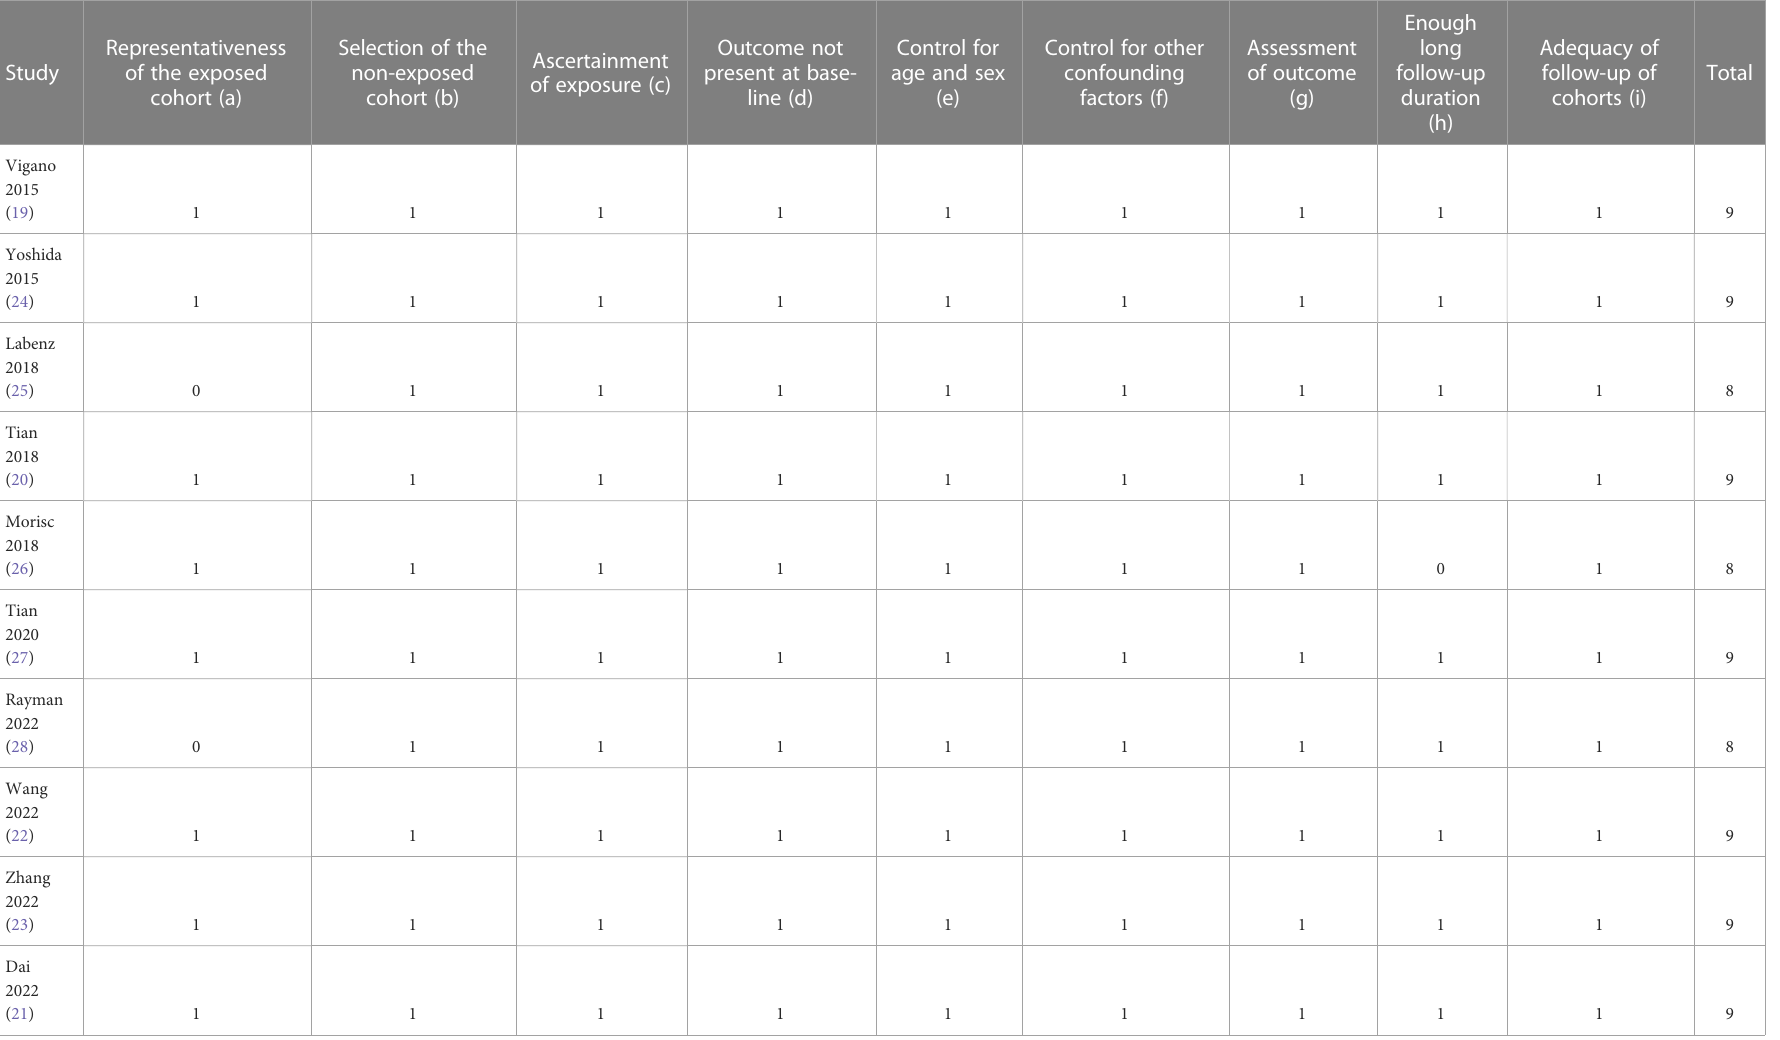
Representativeness Study of the